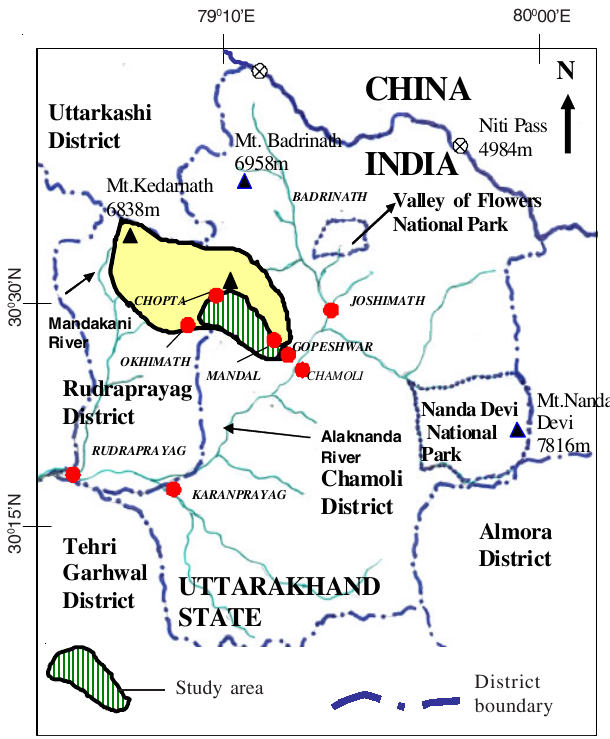
Figure 1. Map of Chamoli and Rudraprayag districts in Garhwal, Uttarakhand state, depicting the location of the study area in Kedarnath Musk Deer Reserve and sites as mentioned in the